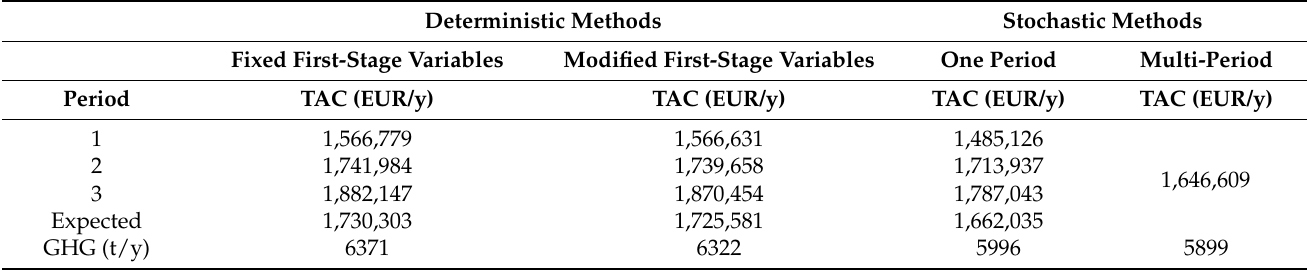
Table 9. Comparison of HEN results with different approaches (equal time